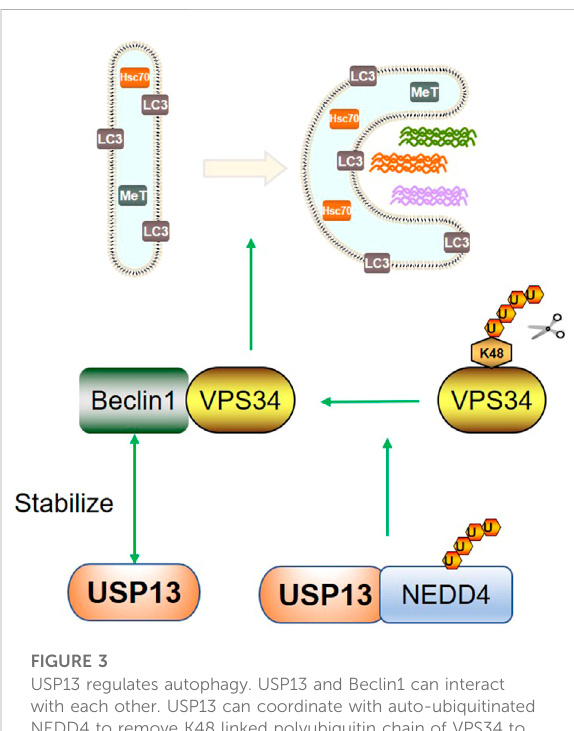
Figure 3 summarized the regulation of USP13 in autophagy.